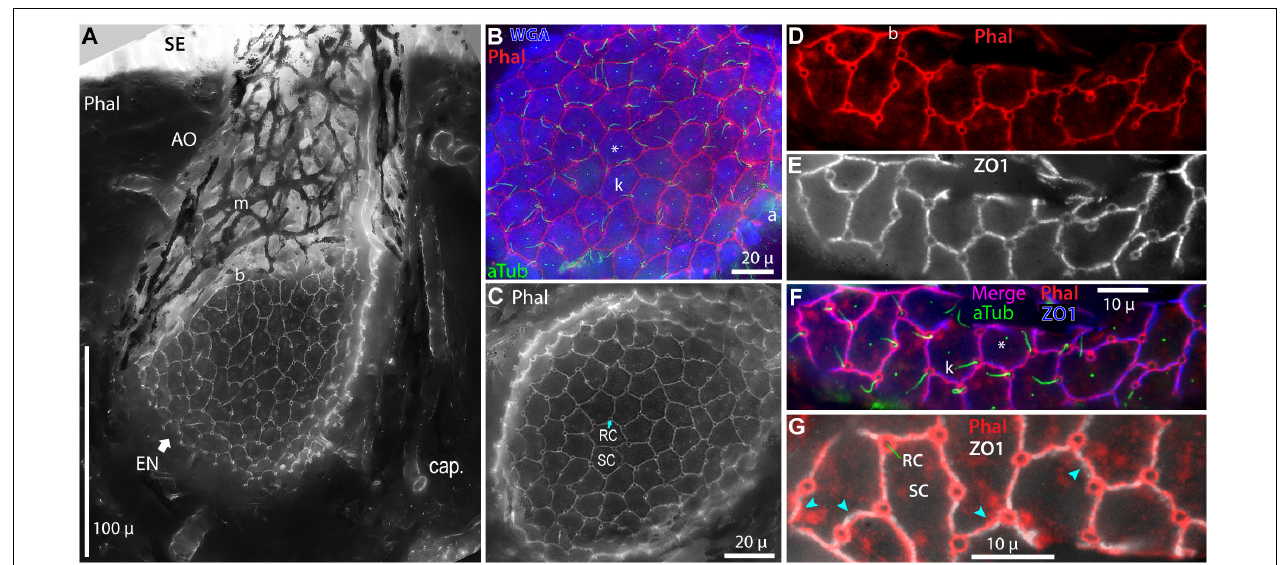
FIGURE 4 | Intercellular junctions on the apical surfaces of electrosensory neuroepithelia, between receptor cells (RC) and support cells (SC), were labeled by phalloidin (Phal) or anti–ZO1, and imaged as projections from stacks. (A) This tangential cross section of an ampullary organ (AO) exposed a large expanse of the apical surface of the electrosensory neuroepithelium (EN), extending to its superficial border (b) with the canal wall. Capillaries (cap.) surrounded the AO. m, Melanin-pigmented mesh of fibers in the AO wall. (B) Phalloidin (Phal) revealed cell borders on the apical surface of this triple-labeled pseudocolored EN. Wheat germ agglutinin (WGA) labeled the apical surfaces of support cells (but not receptor cells). Anti–acetylated α -tubulin (aTub) labeled kinocilia (k) on receptor cells, and also labeled afferent (a) branches, and short cilia ( ) on support cells. (B,C) These large expanses of EN did not include borders with canal wall, and so were basal in their AOs. (D–G) Colocalization of labeling by phalloidin and anti–ZO1. (F,G) Images of different labels were aligned by applying offsets of fluorescence channels based on calibrations from TetraSpeck fluorescent beads. (F) Kinocilia (k) on receptor cells were labeled by anti–aTub to identify the apical membranes of receptor cells; anti–aTub also labeled short cilia ( ) on support cells. (G) Co-labeling of intercellular junctions by phalloidin and anti–ZO1 revealed general colocalization, but with local mismatches or small offsets ( (cid:74) ). (A,C) 40x 0.75 NA water lens. (B) 60x 1.4 NA oil lens. (D–G) 100x 1.25 NA oil lens, 0.4 µ stack step